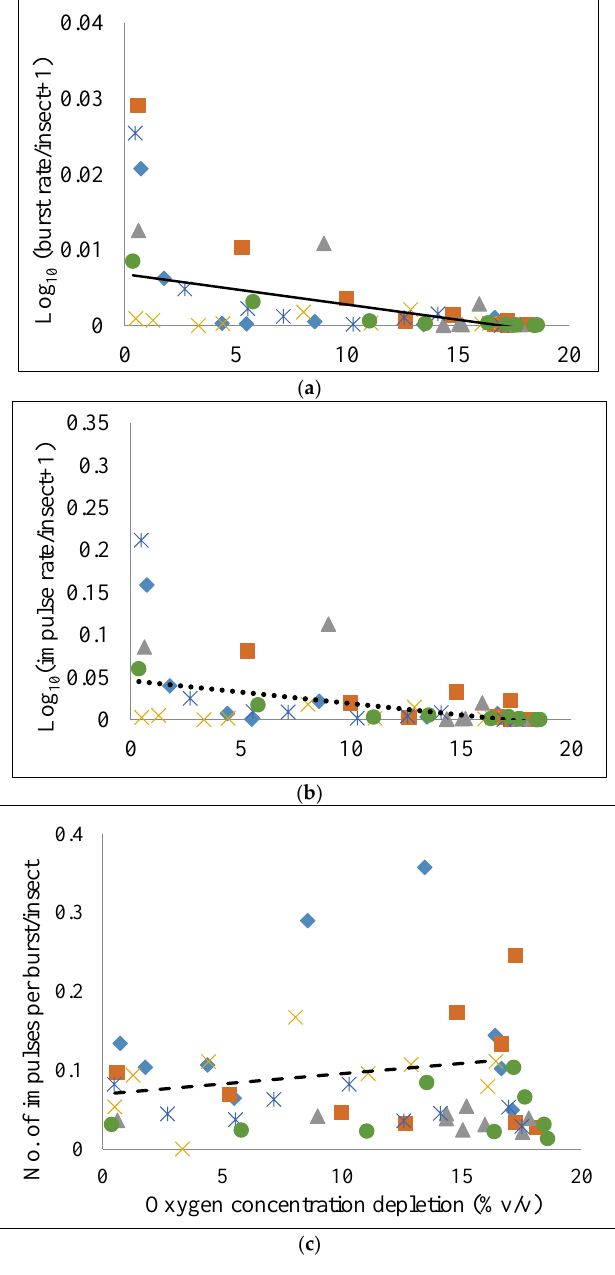
Figure 4. Scatter plot showing the relationship of ( a ) log 10 (burst rate/insect + 1); ( b ) log 10 (rate of impulses in bursts/insect + 1); and ( c ) Number of impulses per burst/insect to the oxygen concentration depletion for 25 Callosobruchus maculatus adults in 500 mL (diamond) and 1000 mL (X) storage jars, 50 adults in 500 mL (square) and 1000 mL (asterisk) storage jars, and 100 adults in 500 mL (triangle) and 1000 mL (circle) storage jars during a 15 d storage